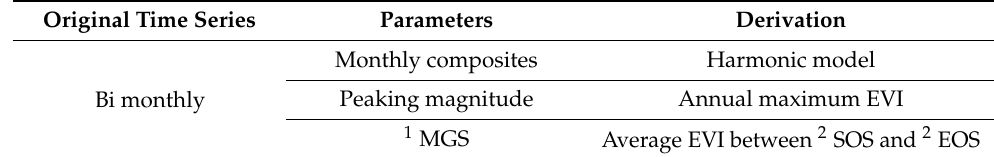
Table 1. Original data set and its derivation for time series